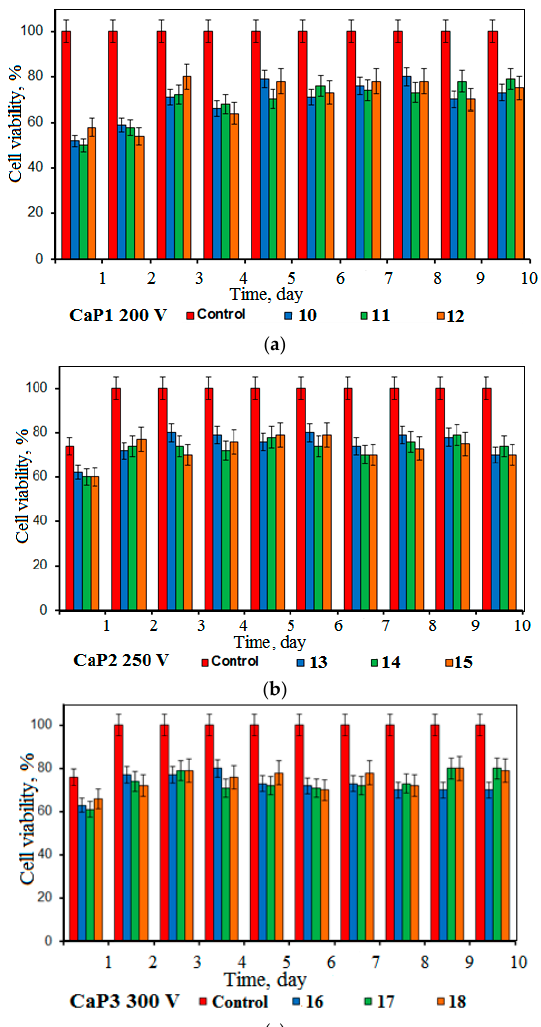
Figure 10. Results of the in vitro cytotoxic test of the CaP coating extracts for the Neuro-2a cell line compared with the control (100% viable cells). ( a ) CaP1; ( b ) CaP2; ( c ) CaP3.